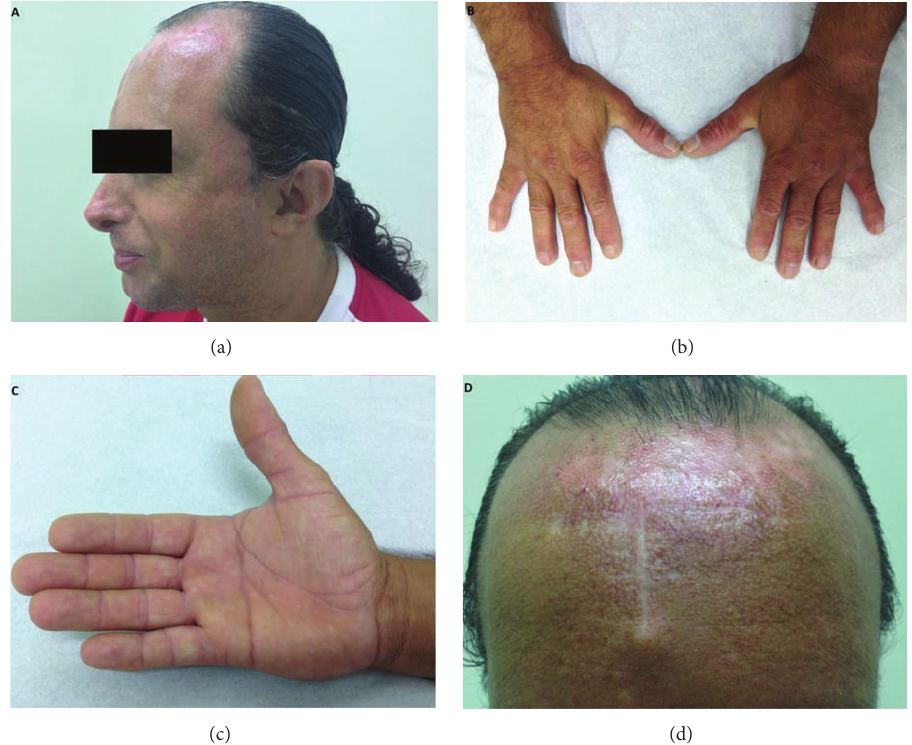
Figure 2: (a) Dolichocephaly, beaked nose, and prominent ears. (b) Clinodactyly and dystrophic nails. (c) Palmar transverse crease. (d)